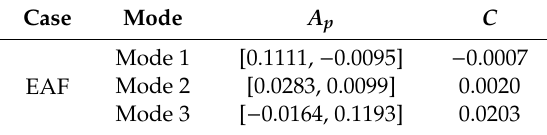
Figure 10. Clustering results of the 5-th harmonic dataset of the EAF. Table 4. The simplified model parameters of the 5-th harmonic of the EAF.